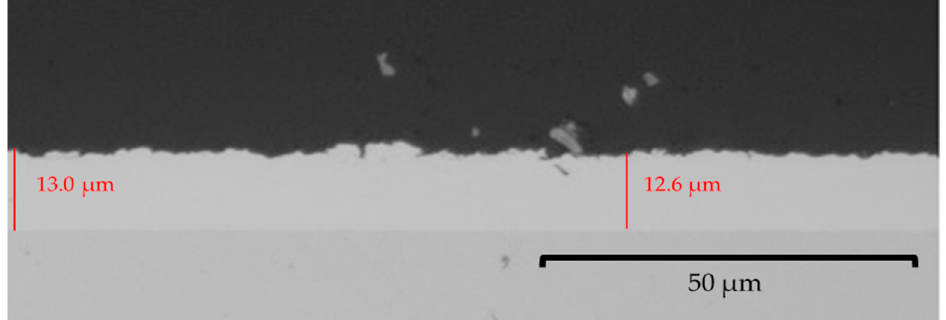
Figure 2. Optical-microscopic grey scale image of the cross-section from a Cu − Sn layer (0.5 A/dm 2 , 95 °C, 100 rpm, 10,800 s) with 85% mass fraction of copper deposited outside the glove box.